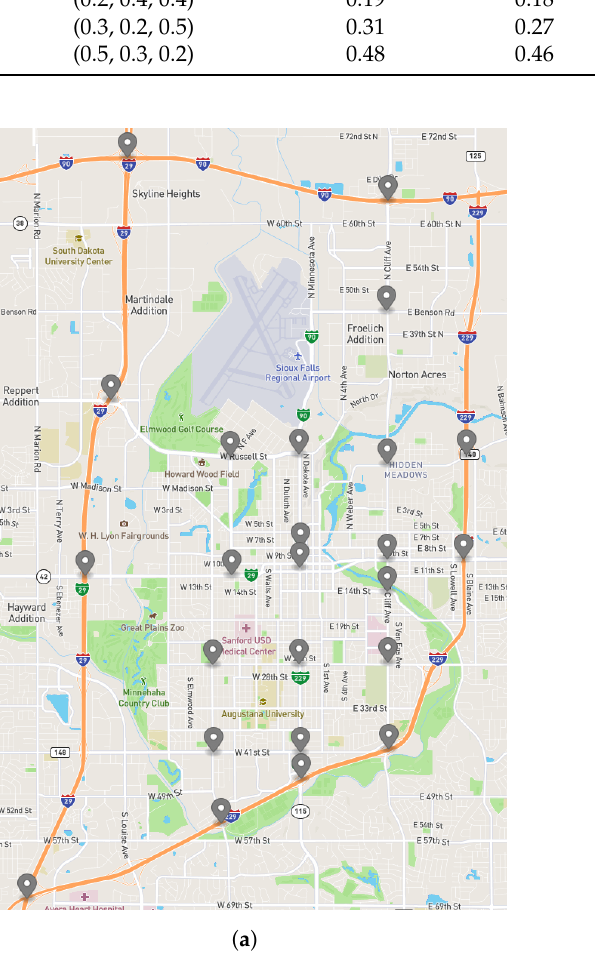
Figure 1. Transportation network used for experiments, ( a ) Map of Sioux Falls, ( b ) Complex network model of Sioux